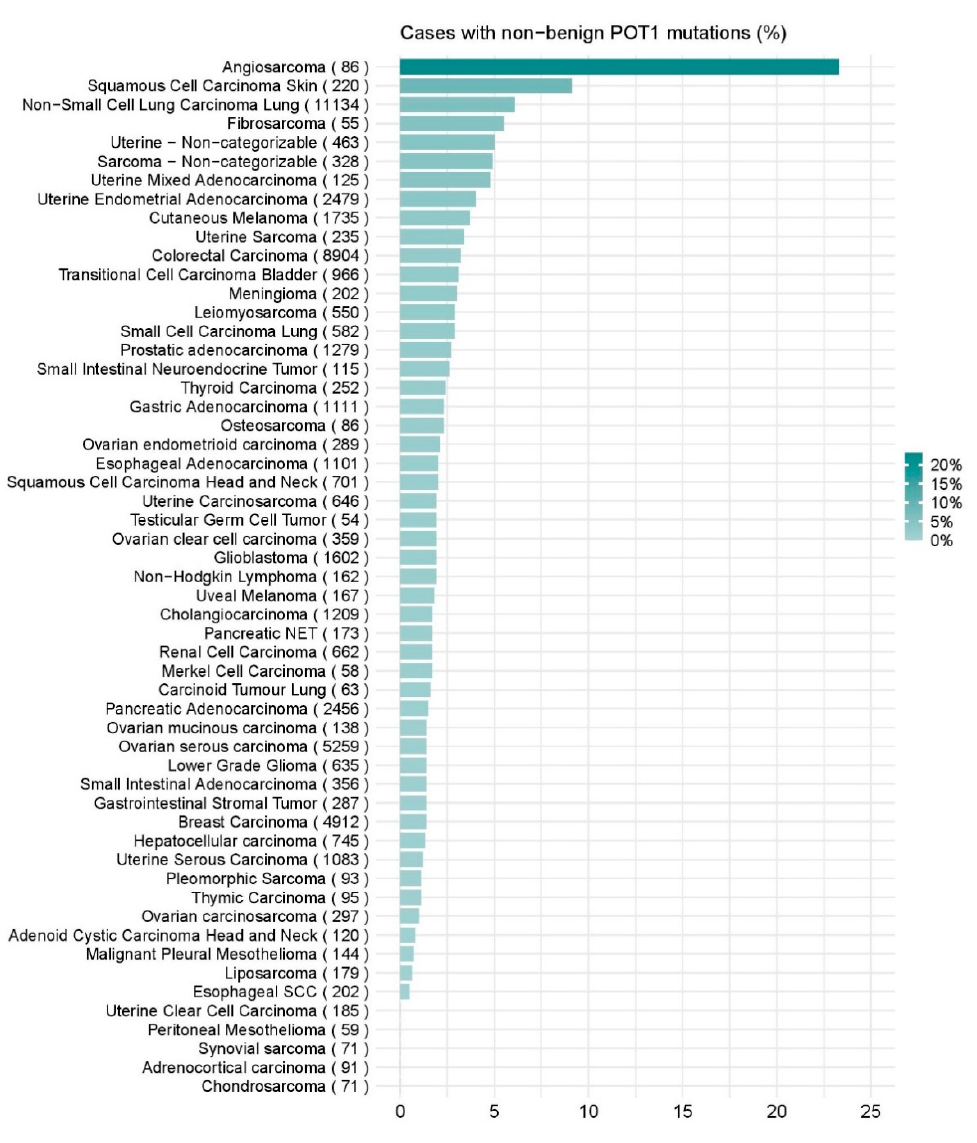
Figure 2. Burden of non-benign POT1 mutations across cancer types. The prevalence of POT mutations defined as neither “presumed benign” nor “benign” was investigated in 62,368